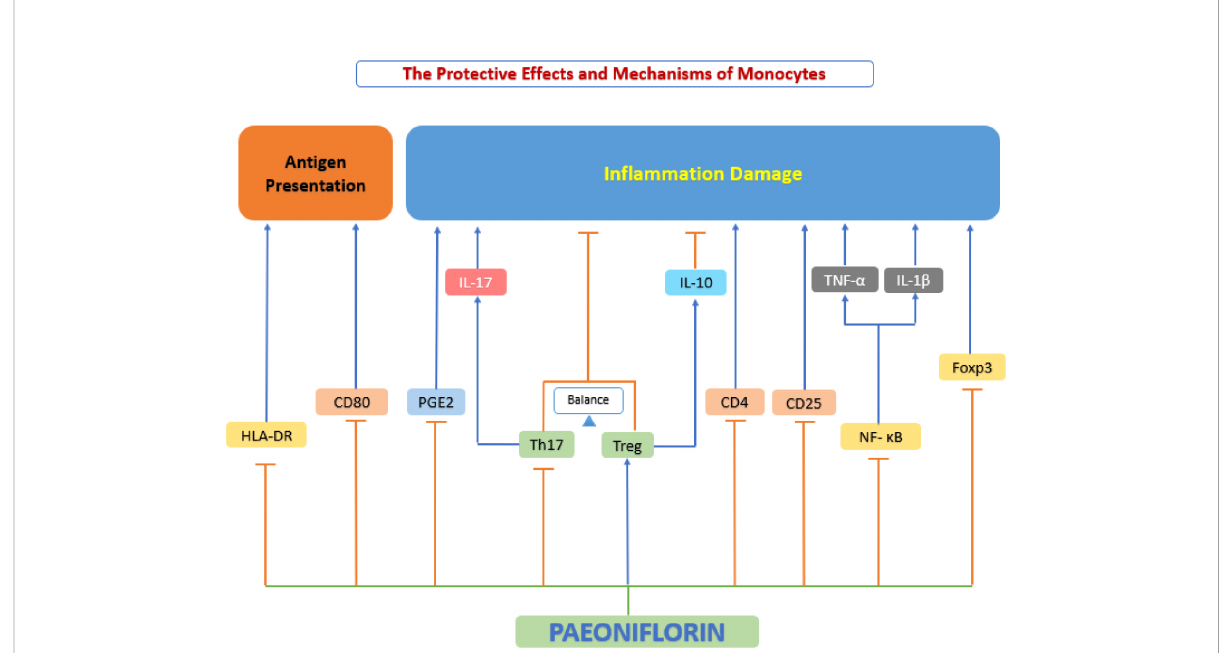
FIGURE 7 The protective effects and mechanisms of paeoni fl orin on monocyte. Paeoni fl orin affects the progression of atherosclerosis by inhibiting phagocytosis and antigen presentation, over proliferation and in fl ammatory factor secretion by monocytes. Foxp3, forkhead box P3; HLA-DR, human leukocyte antigen DR; IL-10, interleukin 10; IL-17, interleukin 17; NF- k B, the nuclear factor-kB; PGE2, prostaglandin E2; Th17, T helper type 17 cell; Treg, Regulatory T